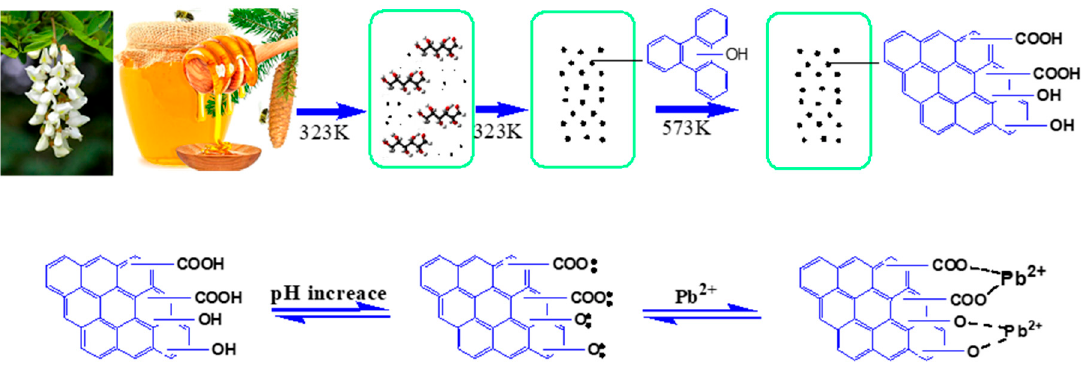
Figure 6. The adsorption mechanism of HHTB.